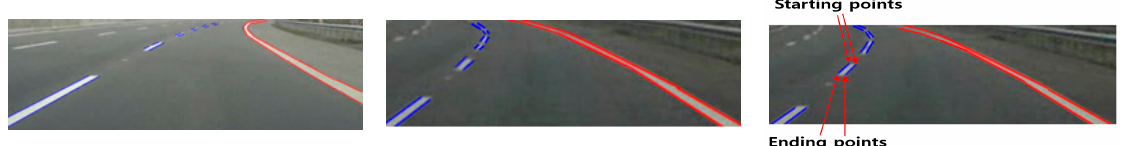
Figure 17. Examples of detection results on curve lanes of SLD datasets by our method (Detected dashed and solid lanes are shown in blue and red colors, respectively).